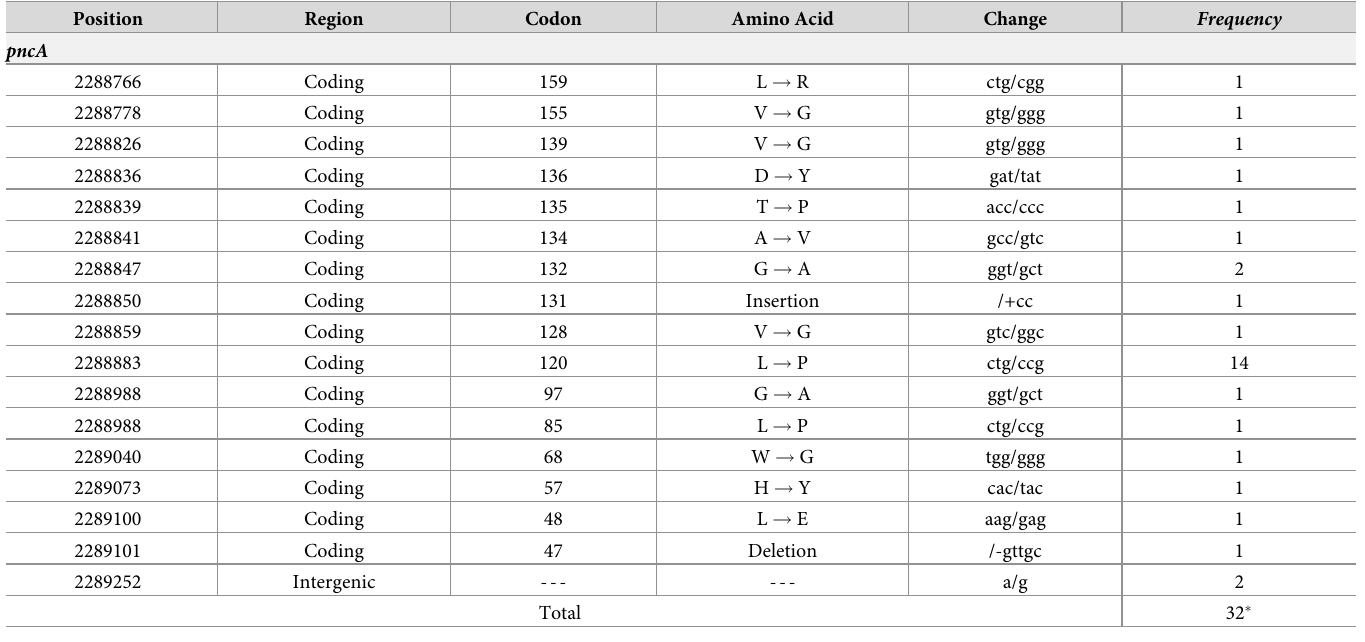
conferring resistance to ofloxacin, and two had one mutation at gyrB , conferring resistance to levofloxacin (Table 6). In addition, five isolates presented mutations at eis and rrs , conferring resistance to kanamycin, amikacin and capreomycin. Finally, no polymorphisms were observed in genes associated with resistance to linezolid ( rrl and rplC ), aminoglycosides ( tlyA ), ethionamide ( ethR , mshA , inhA , ndh and ethA ) and p-amino salicylic acid ( thyA ). A joint analysis of MDR-TB isolates with the mutations related to resistance against sec- ond-line drugs showed the presence of eight isolates that could potentially be considered as pre-XDR-TB (with resistance to H and R, associated with resistance to FQ or a second-line